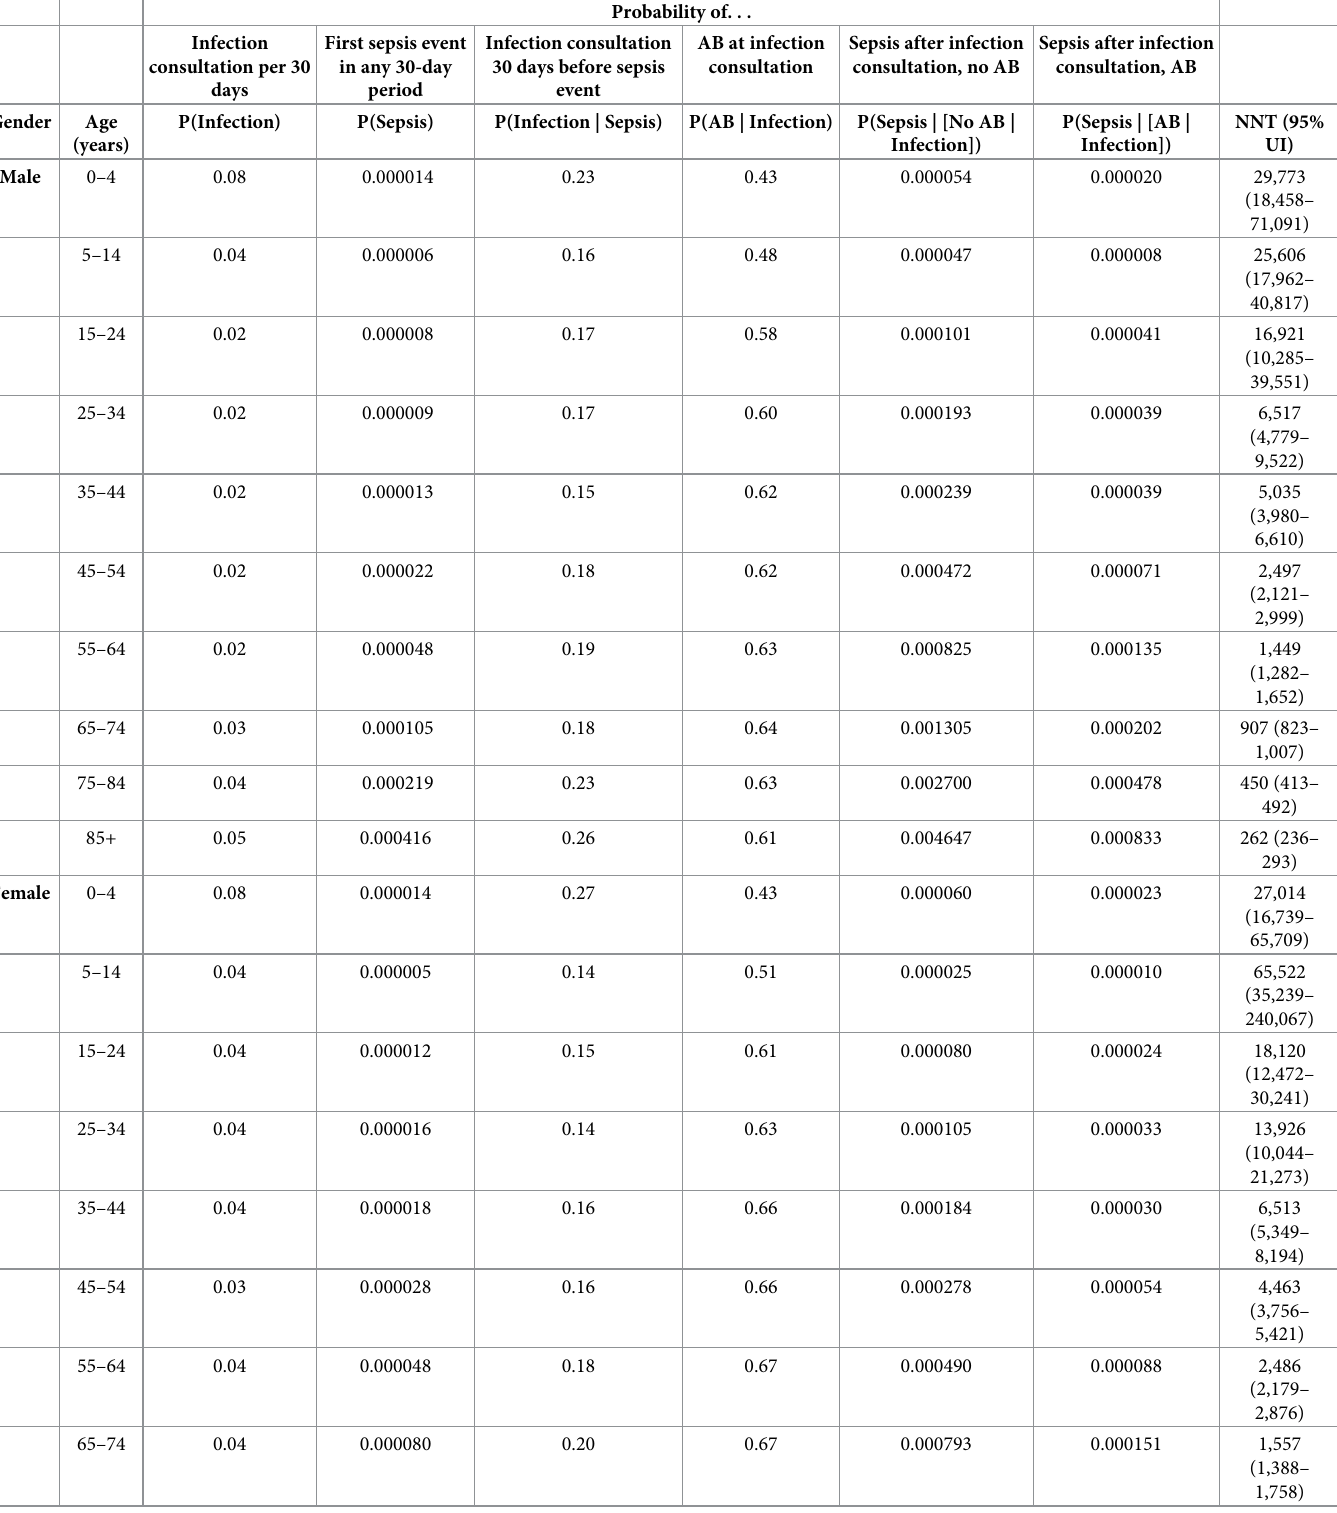
Table 3. Probability of sepsis after infection consultations in primary care.